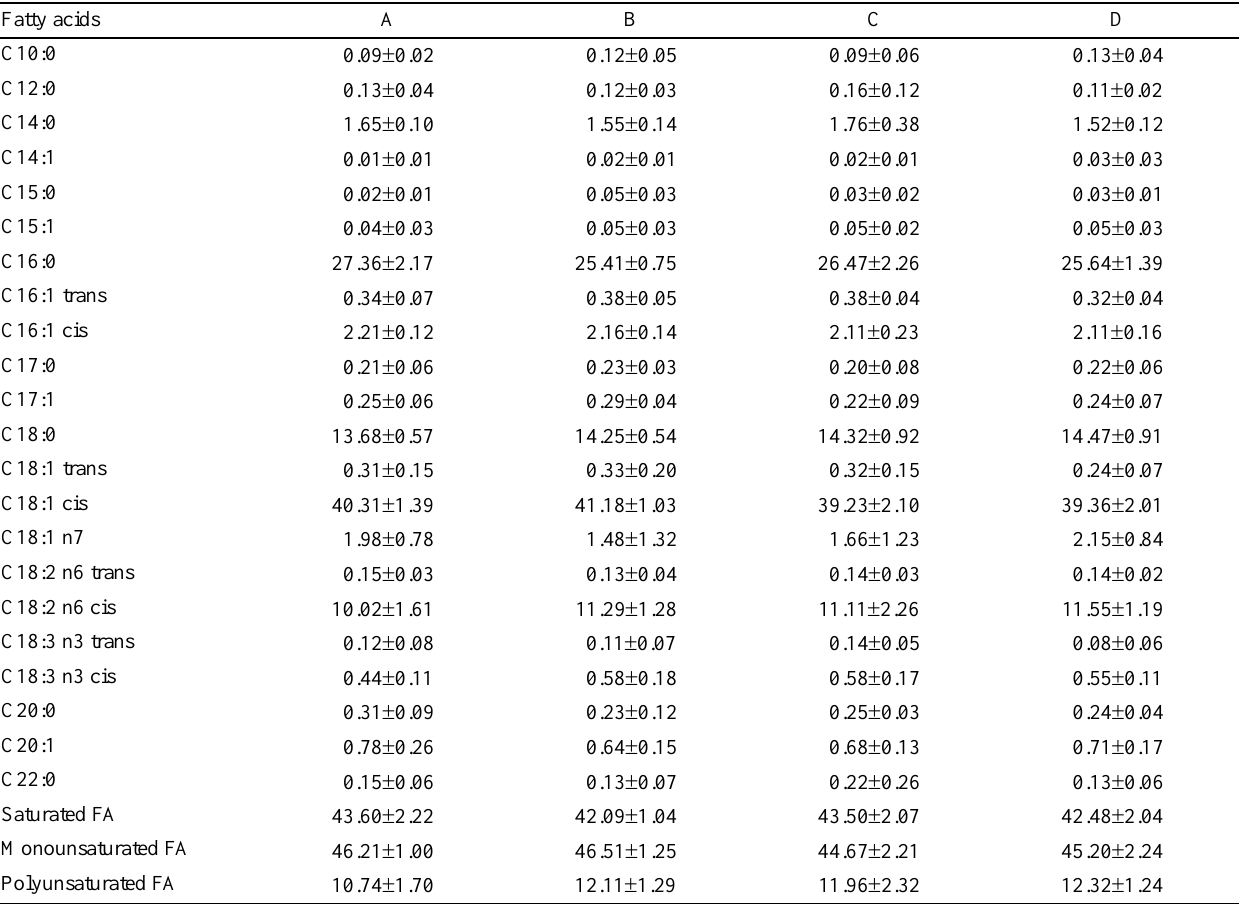
Groups did not differ significantly